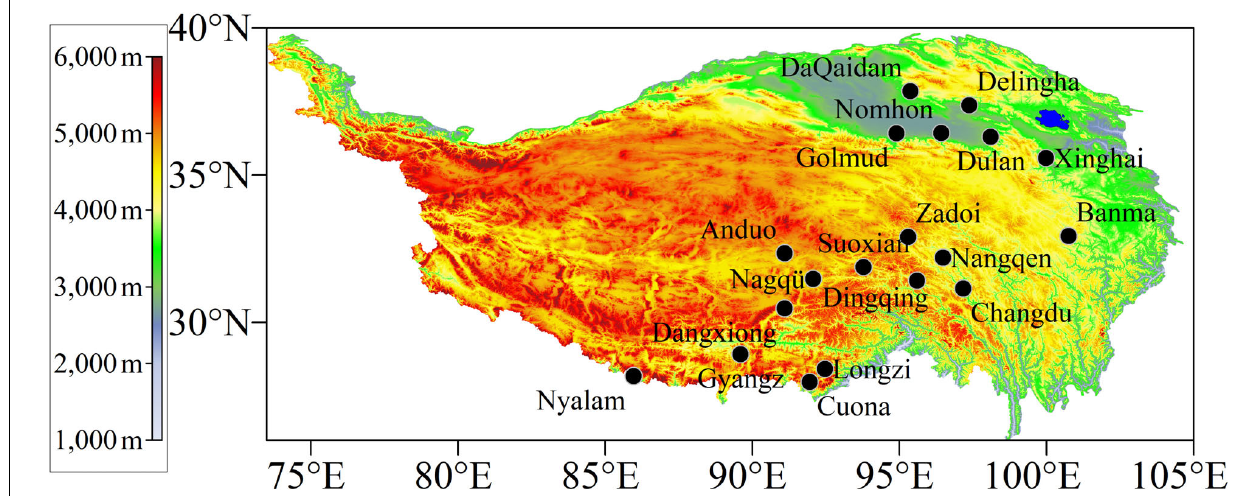
FIGURE 1 | Distribution of the 19 in-situ observations used in this study.